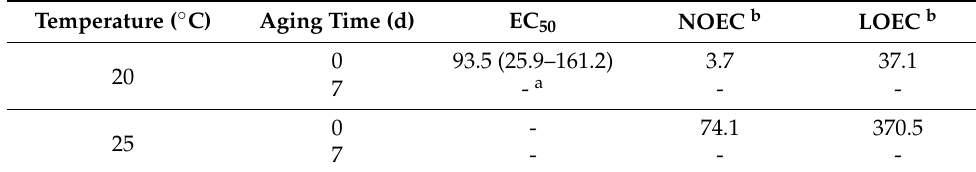
Figure 1. The number of surviving adults ( ○ ) and produced juveniles ( ● ) of Allonychiurus kimi (Lee) after 28 d of exposure to glyphosate in OECD artificial soil at different temperatures (20 °C and 25 °C) and aging times (0 day and seven days); ( a ) 0 day of aging at 20 °C. ( b ) Seven days of aging at 20 °C. ( c ) 0 day of aging at 25 °C. ( d ) Seven days of aging at 25 °C. The data are presented as the mean ± standard deviation (per test vessel; n = 5). The solid lines are the number of juveniles estimated by fitting the data to the logistic model proposed by Haanstra et al. (1985). Asterisks indicate significant differences from each control (Dunnett’s post hoc test; p < 0.05). Table 1. Median effective concentration (EC50) with corresponding 95% confidence intervals, no ob- served effect concentration (NOEC), and lowest observed effect concentration (LOEC) of glyphosate on the reproduction of Allonychiurus kimi (Lee) after 28 days of exposure to glyphosate in artificial soil at two temperatures (20 ◦ C and 25 ◦ C) and aging times (0 day and seven days) estimated using the logistic model presented by Haanstra et al.